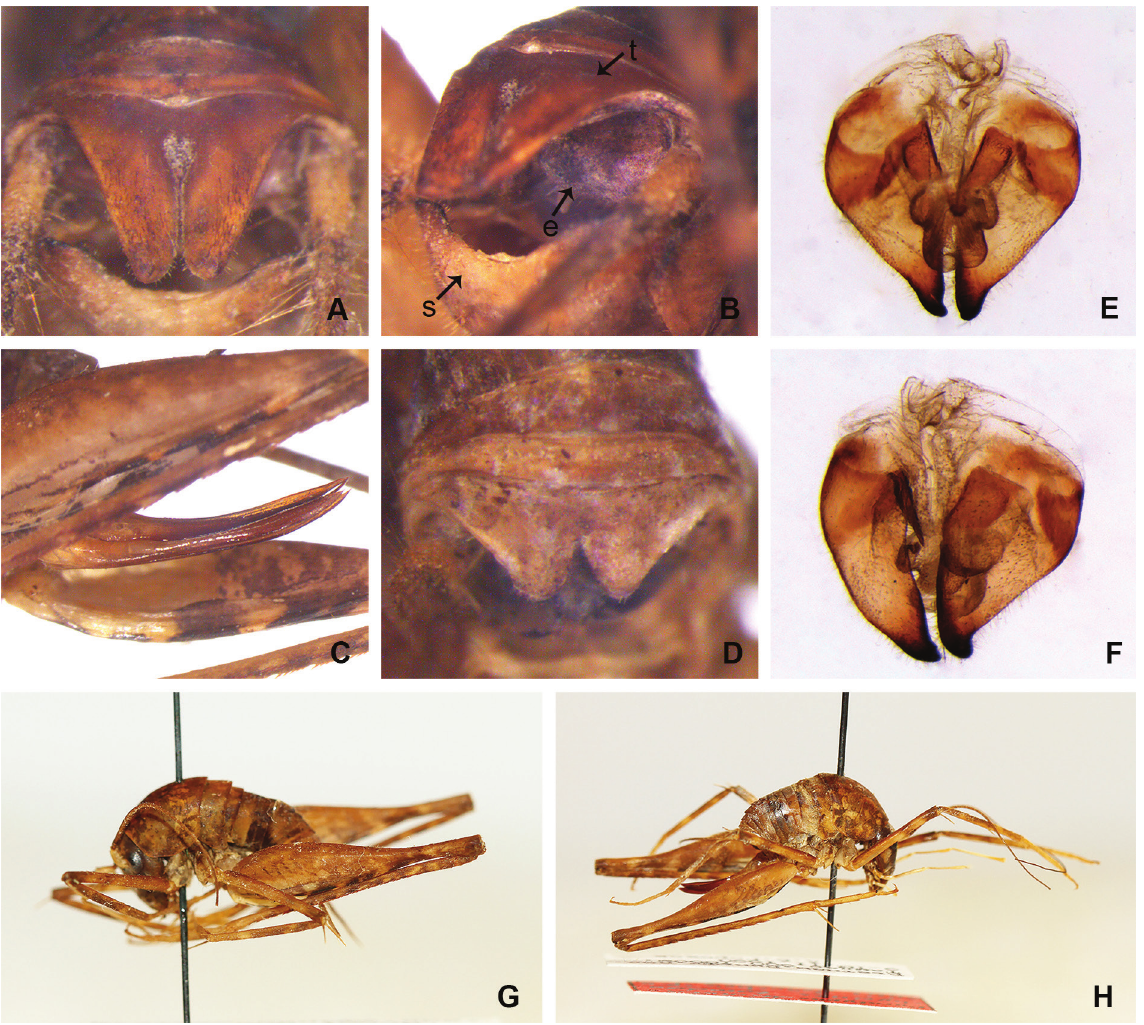
Fig. 1. Microtachycines tamdaonensis Gorochov, 1992. A – B , E – G . Holotype, ♂ (ZIN). A . Tenth abdominal tergite in dorsal view. B . Epiproct. E – F . Genitalia. E . Dorsal view. F . Ventral view. G . Habitus in lateral view. C – D , H . Paratype, ♀ (ZIN). C . Ovipositor in lateral view. D . Tenth abdominal tergite in dorsal view. H . Habitus in lateral view. Abbreviations: e = epiproct; s = subgenital plate; t = tenth abdominal